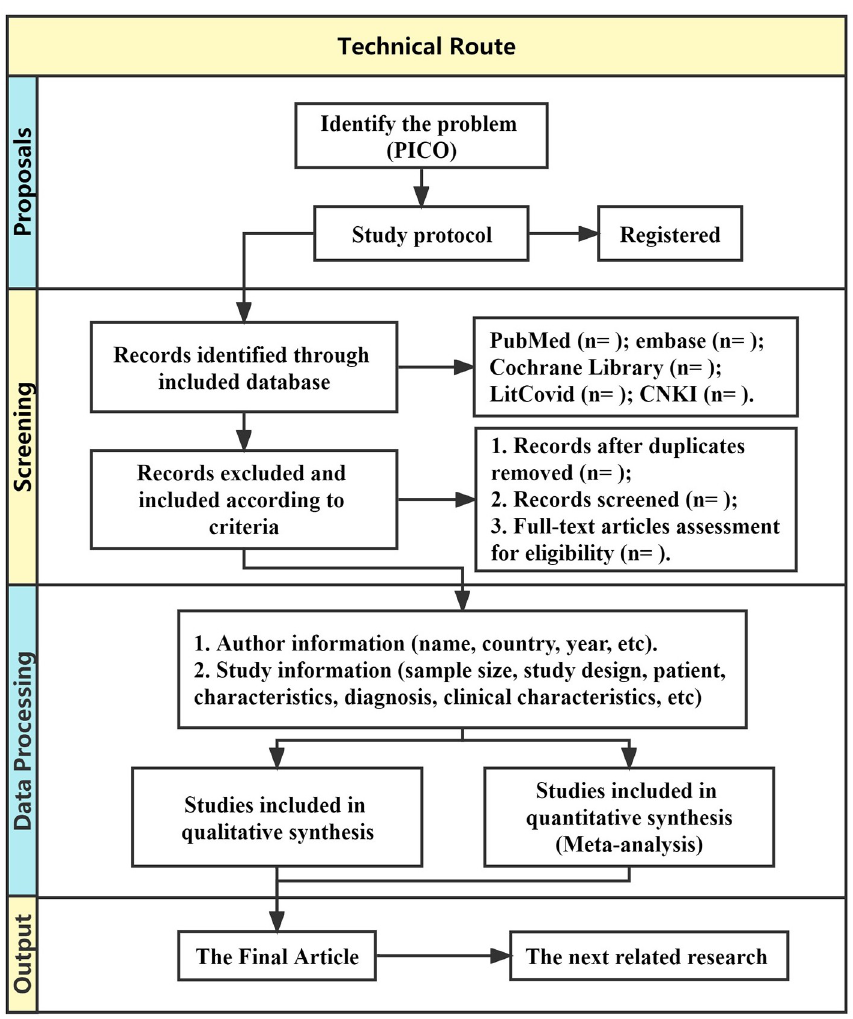
Fig 2. Flow chart of the study